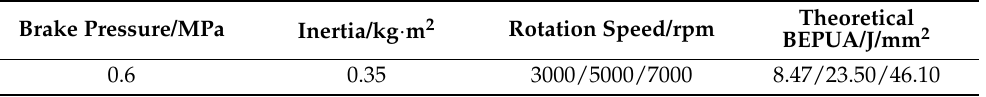
Table 5. The test parameters of